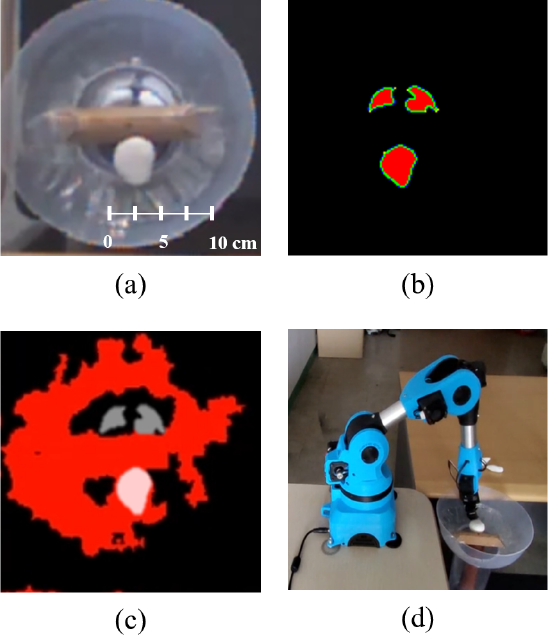
Figure 13. Experimental results obtained using the proposed smart hopper system in a case involving two rocks under the hopper and one across of the hopper. ( a ) RGB image, ( b ) binary image of detected rock, ( c ) classified rock based on depth image, and ( d ) operation of the robot arm.